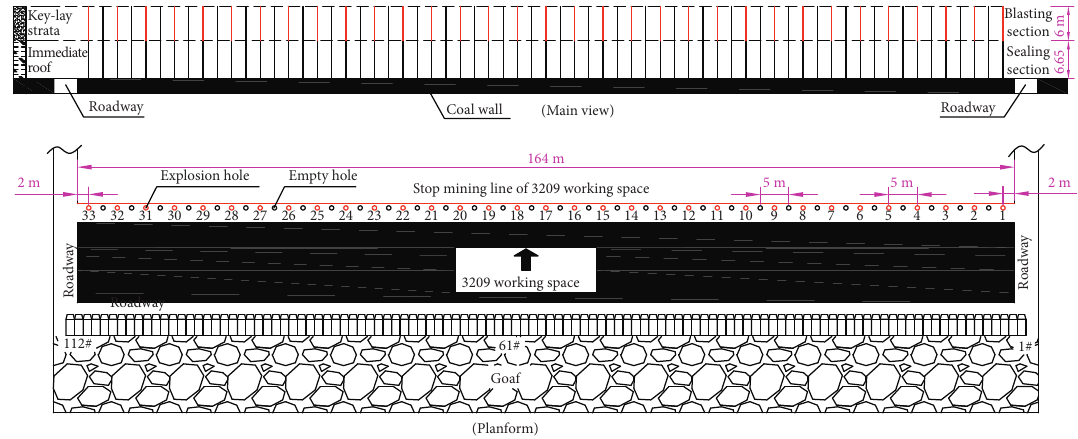
Figure 12: Layout of roof-cutting